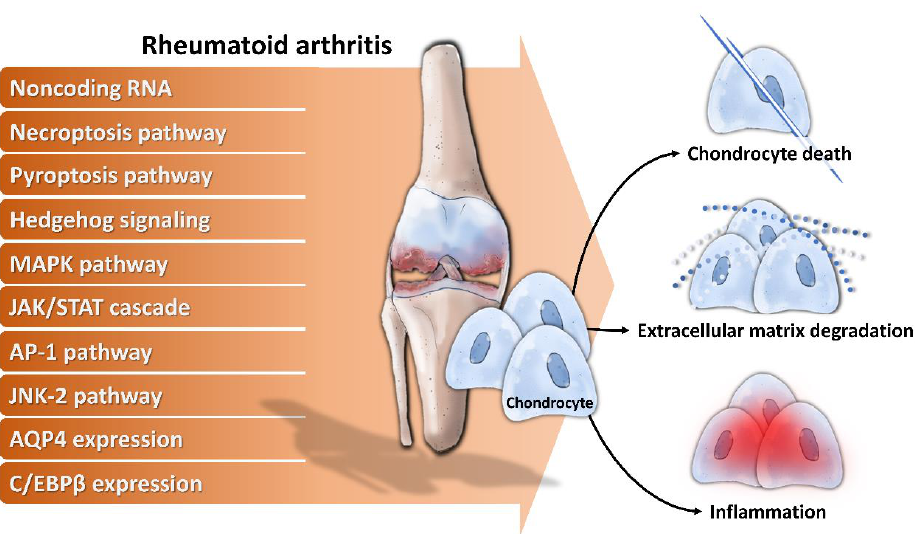
Figure 1. Mechanisms of chondrocytes dysfunction in rheumatoid arthritis. Noncoding RNA and activation of necroptosis pathway, pyroptosis pathway, hedgehog signaling, mitogen-activated protein kinase (MAPK) pathway, Janus kinase / Signal transducer and activator of transcription protein (JAK / STAT) cascade, AP-1 pathway, c-Jun N-terminal kinase 2 (JNK-2) pathway, combined with enhanced aquaporin-4 (AQP4) expression and CCAAT / enhancer binding protein β (C / EBP β ) contribute to increased chondrocyte death, ECM degradation and inflammation.